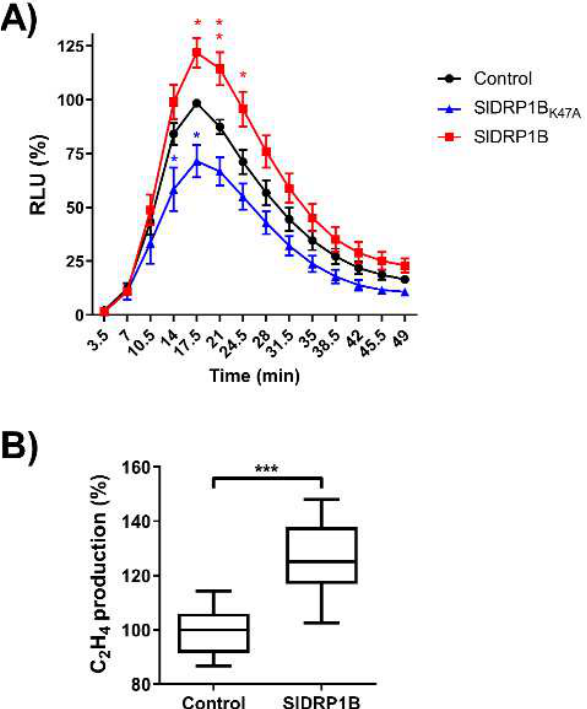
Figure 4. Effect of overexpression of SlDRP1B on LeEIX2-mediated defense responses. Leaf disks of N. tabacum transiently expressing SlDRP1B-tagged, SlDRP1B K47A -tagged, or free-tag (control) were